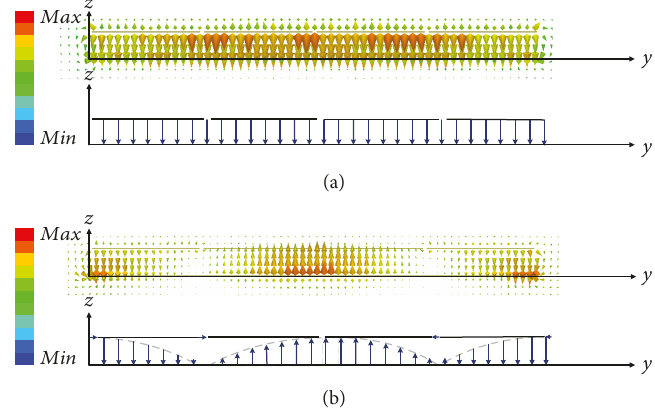
Figure 7: Simulated E - fi eld distribution of the PSMS antenna (upper) and expected E - fi eld distribution based on the cavity model (lower) in x = 33 mm plane (ground plane is located on z = 0 mm plane) at (a) 4.83 and (b) 5.48GHz,